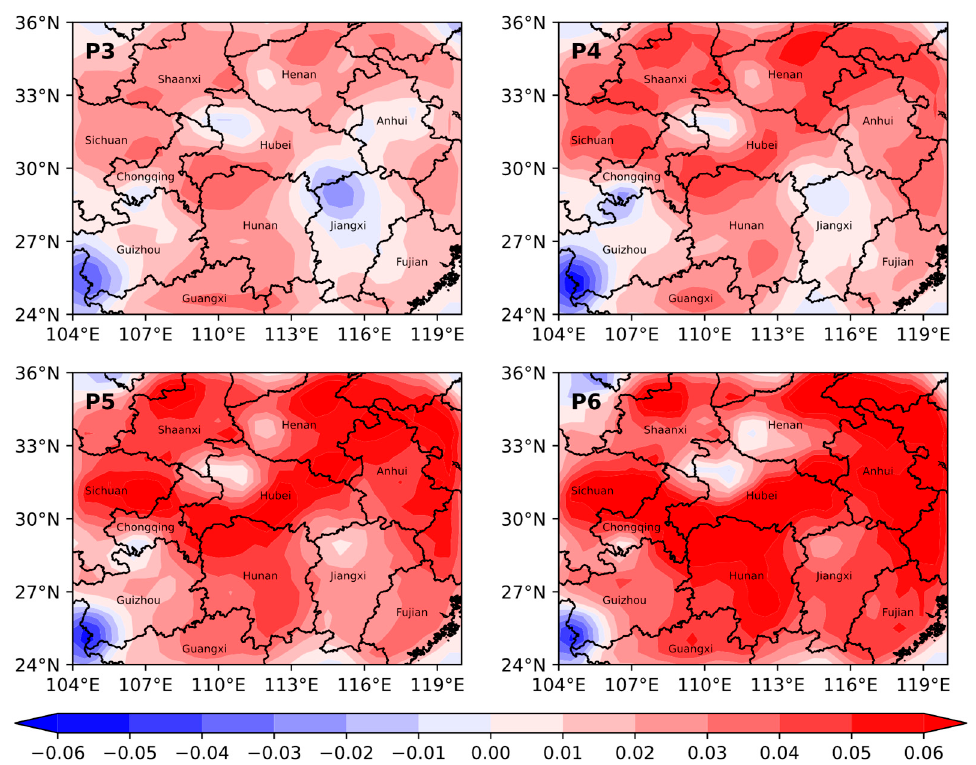
Figure 10. The decline in soil moisture (shading; m 3 m − 3 ) in P3–6 compared with P1 in the control run. The data have been subjected to a 3-by-3 kernel